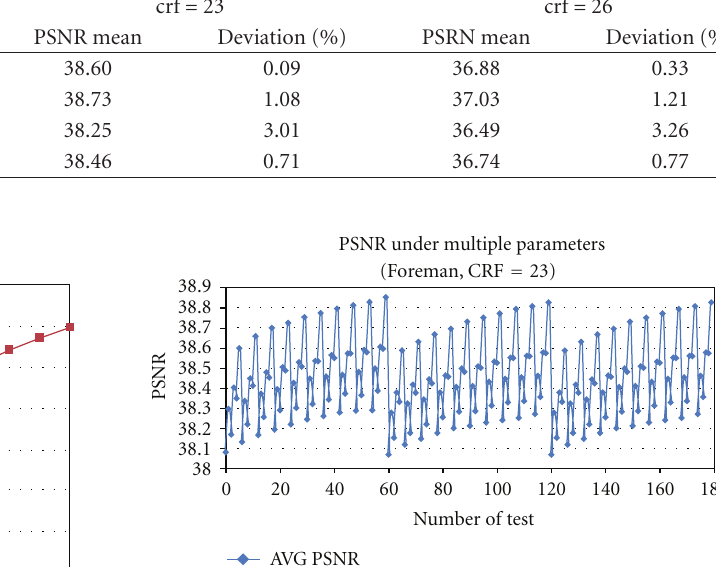
Figure 20: PSNR under combinations of four parameters (Fore- man, crf =